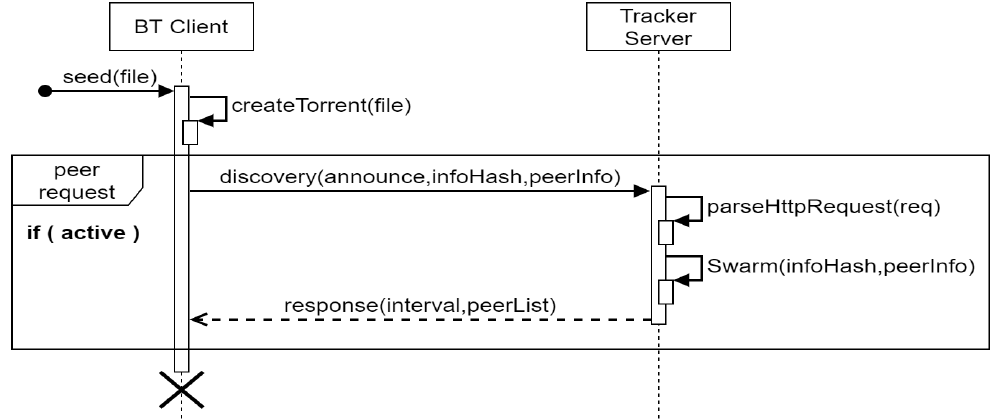
Figure 1. The seeding process of BitTorrent (BT) .